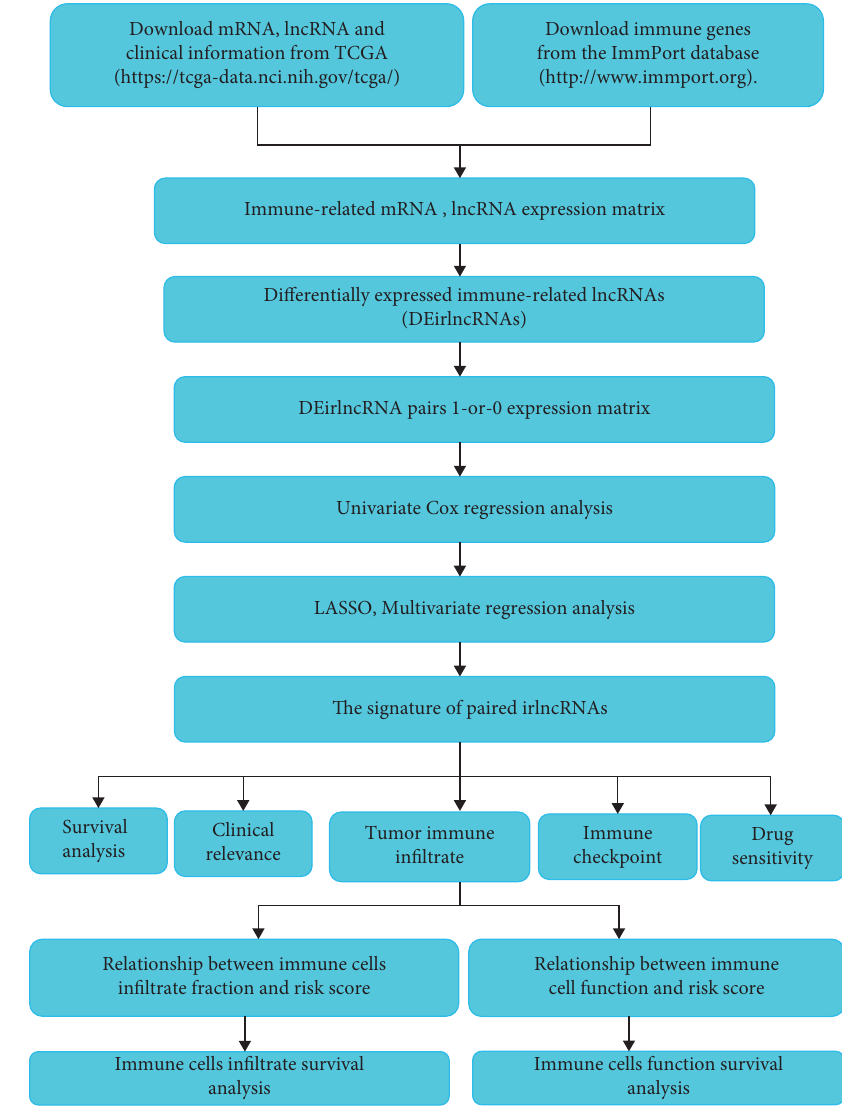
Figure 1: The flowchart of our